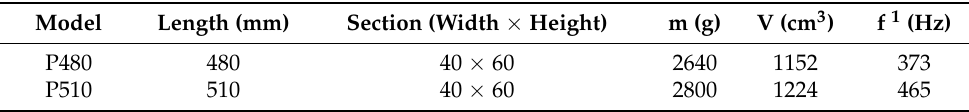
Table 6. The specifications of the models in the simulation.